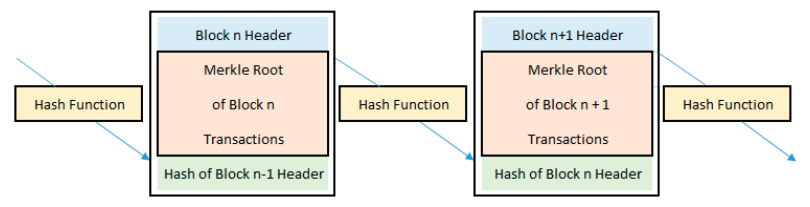
Figure 1. The basic structure of the blockchain [7].